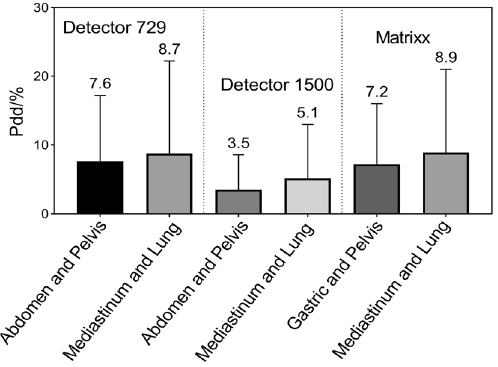
Figure 11. Bar charts display Pdd/% results at various anatomical